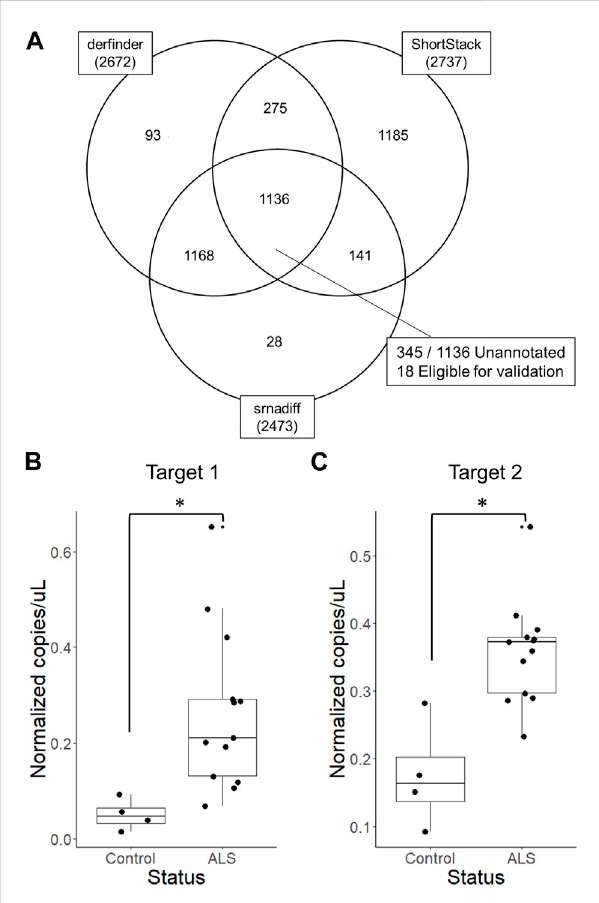
FIGURE 4 Validation of differentially expressed unannotated regions by reverse transcription digital droplet PCR (A) Two unannotated regions were chosen based on der fi nder, ShortStack, and srnadiff results and validated using reverse transcription digital droplet PCR. Targets were signi fi cantly differentially expressed unannotated regions identi fi ed by der fi nder, ShortStack and srnadiff, that do not align to exogenousgenomesorknownfeatures. (B) The fi rsttargetregionwas locatedatchr1:186673706 – 186673729(hg19) and (C) thesecondwas located at chr8:125980908 – 125980931 (hg19). * p < 0.05, Wilcoxon rank-sum exact